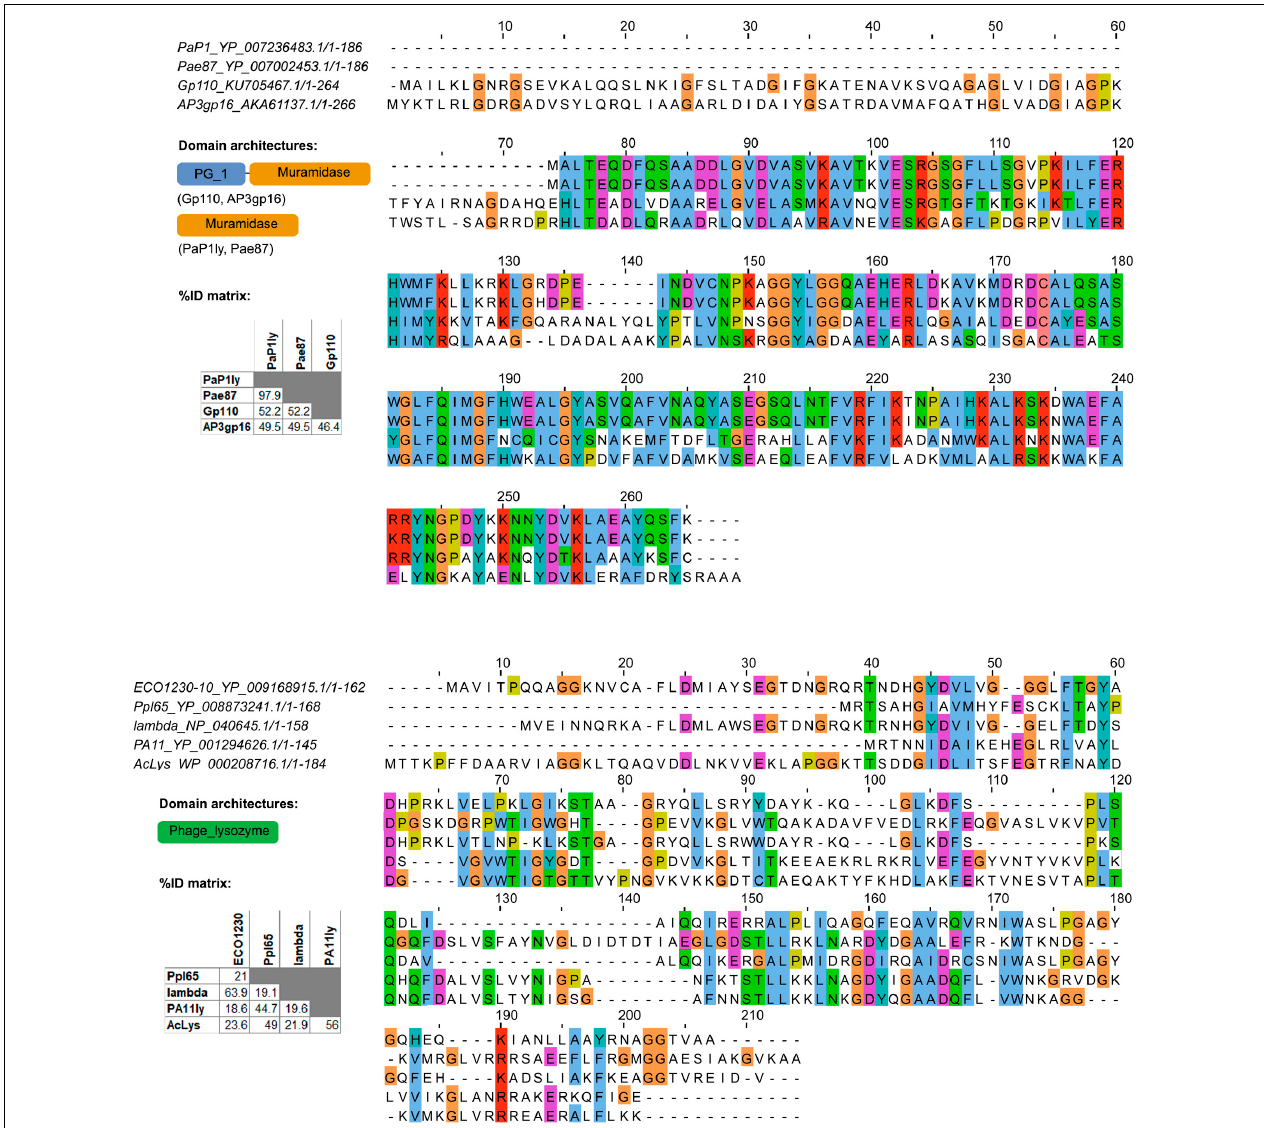
FIGURE 4 | Multiple sequence alignments of Pae87, Ppl65, and other reported lysins belonging to the same enzymatically active domain (EAD) families. Conserved amino acids (aa) are colored, and domain architectures present among the analyzed lysins and respective percent identity matrices are also